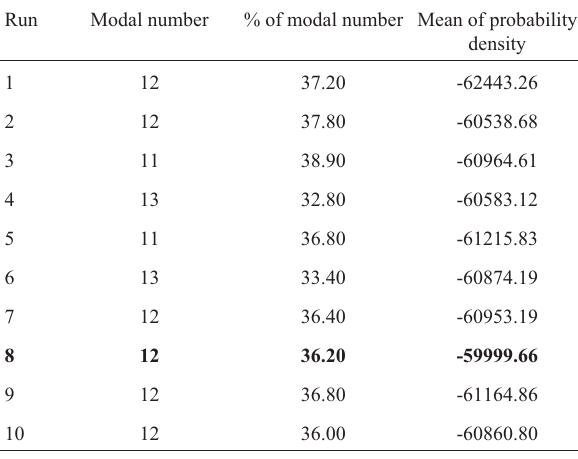
Table 3 - Multiple runs for inferring the number of populations using GENELAND software.